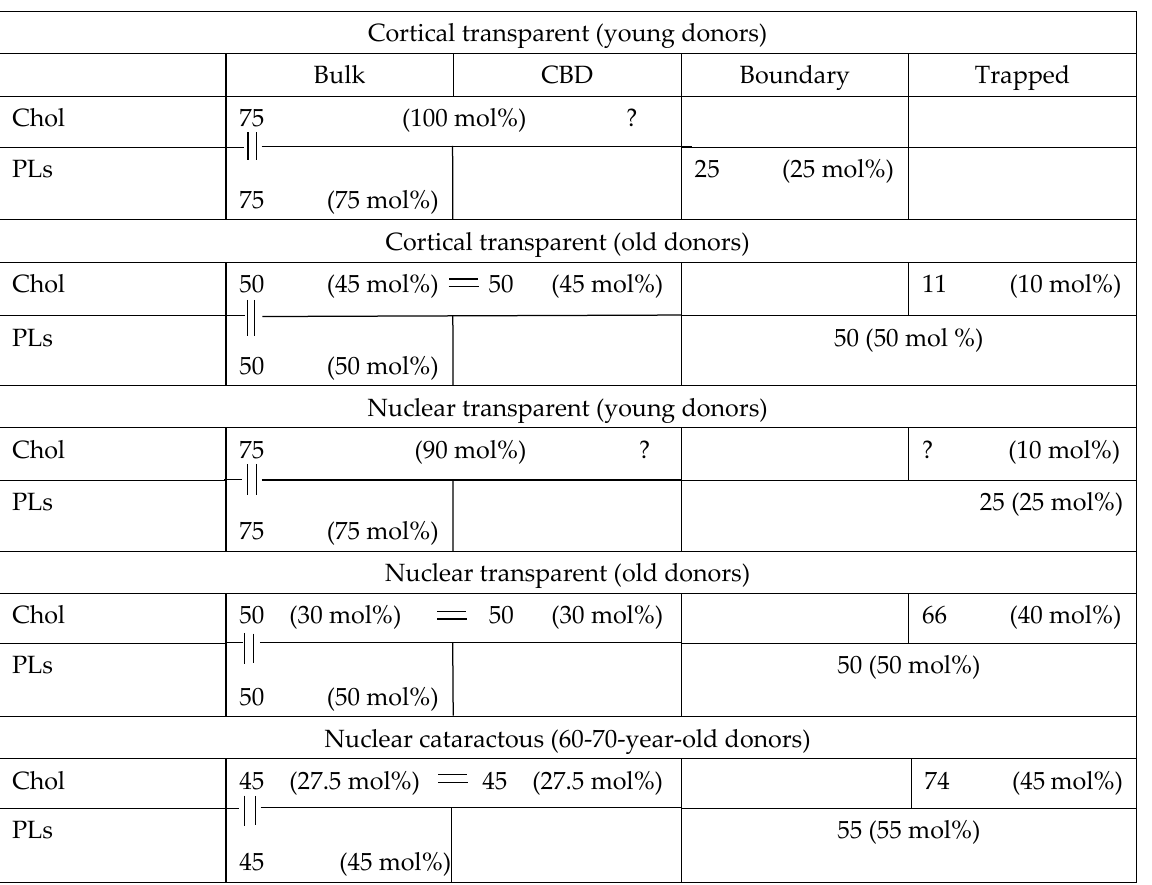
Table 1. Relative amounts of Chol and PLs in domains of intact, cortical, and nuclear fiber cell plasma membranes (expressed as mol% of total Chol or total PLs) from transparent lenses of young (0 to 20 years old) and old (60 to 80 years old) donors and in membranes from lenses with nuclear cataracts from 60- to 70-year-old donors. The numbers of Chol and PL molecules in these domains are evaluated considering the constraints connecting the numbers of Chol and PL molecules in certain domains. Data for mol%s are averaged from the present paper and our previous publications [9,10]. Only the ages of the donors are considered.